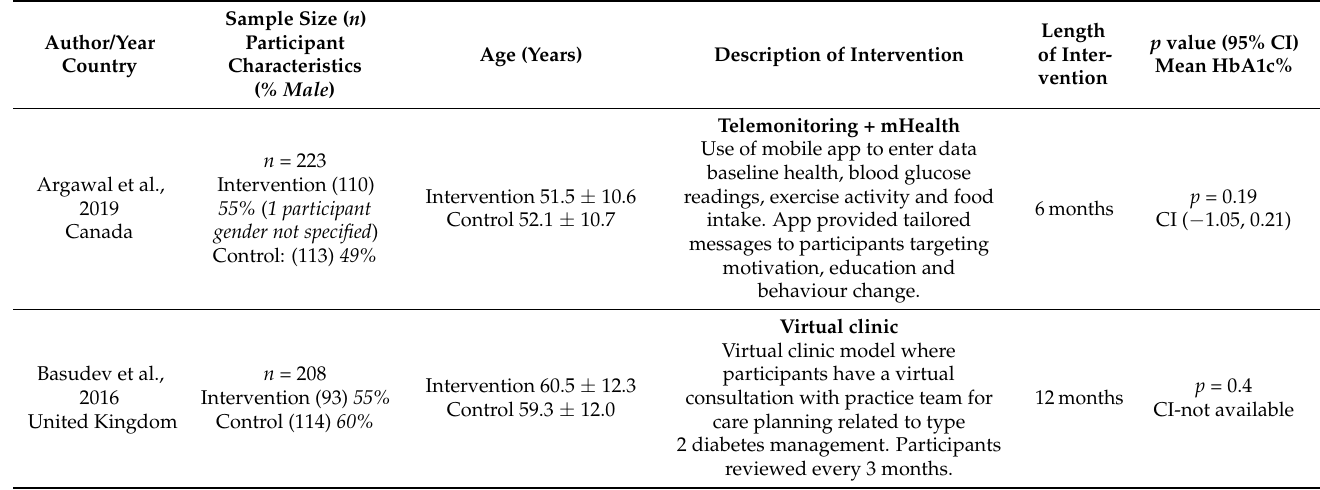
Table 1. Characteristics of the included RCT studies ( n =